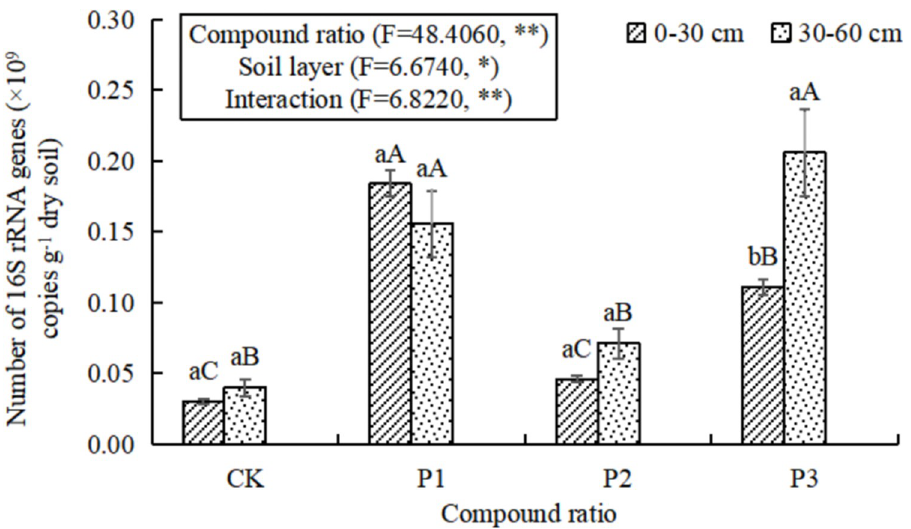
Fig 1. The abundance of 16S rRNA of soil bacteria with different compound ratios. Lowercase letters indicate significant differences between different soil layers under the same treatment (P < 0.05), and capital letters indicate significant differences between different treatments on the same soil layer (P <